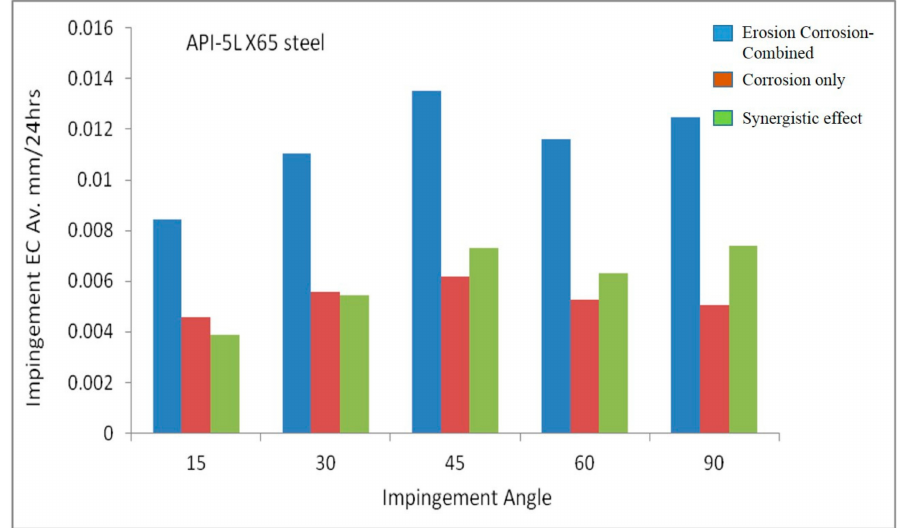
Figure 8. The synergistic effect of erosion on corrosion with the introduction of solid particles on material